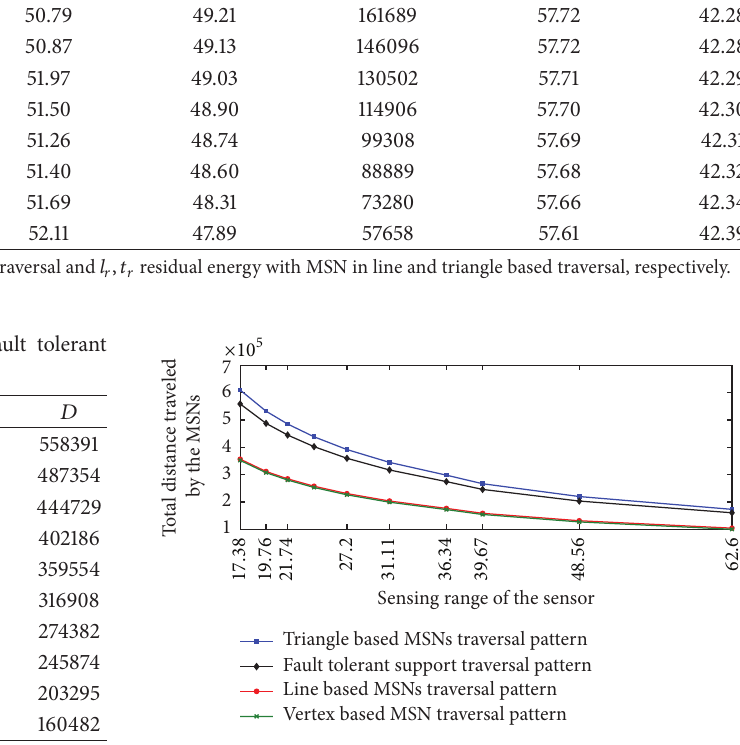
Figure 9: Distance traveled by the MSNs in fault and nonfault tolerant traversal. from 17.38 units to 62.60 units, the percentage of reduction decreases from 36.14% to